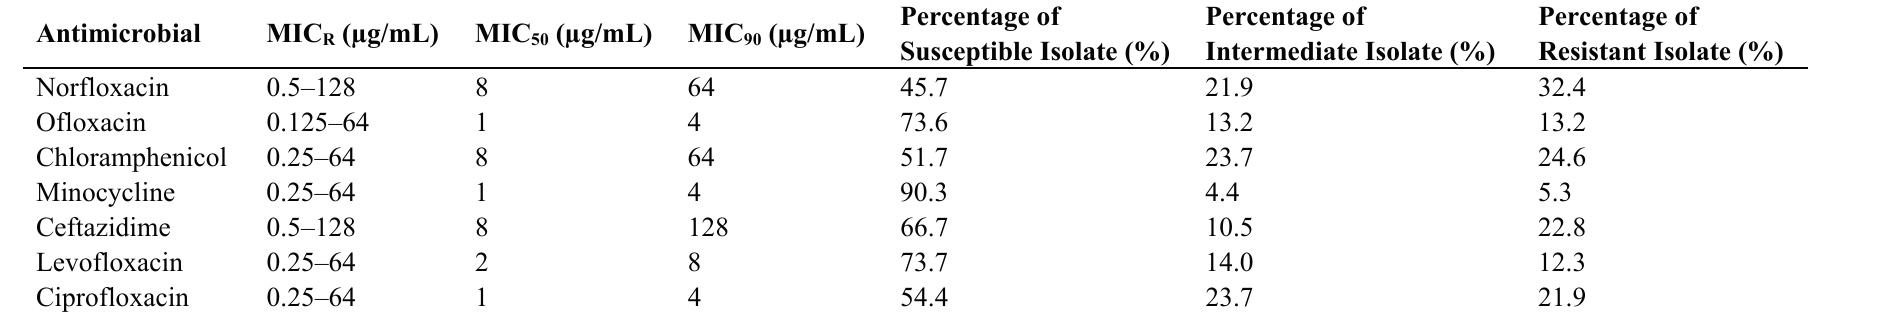
Table 5. In vitro susceptibility of Stenotrophomonas maltophilia to 7 antimicrobials ( n = 114). (µg/mL) MIC R